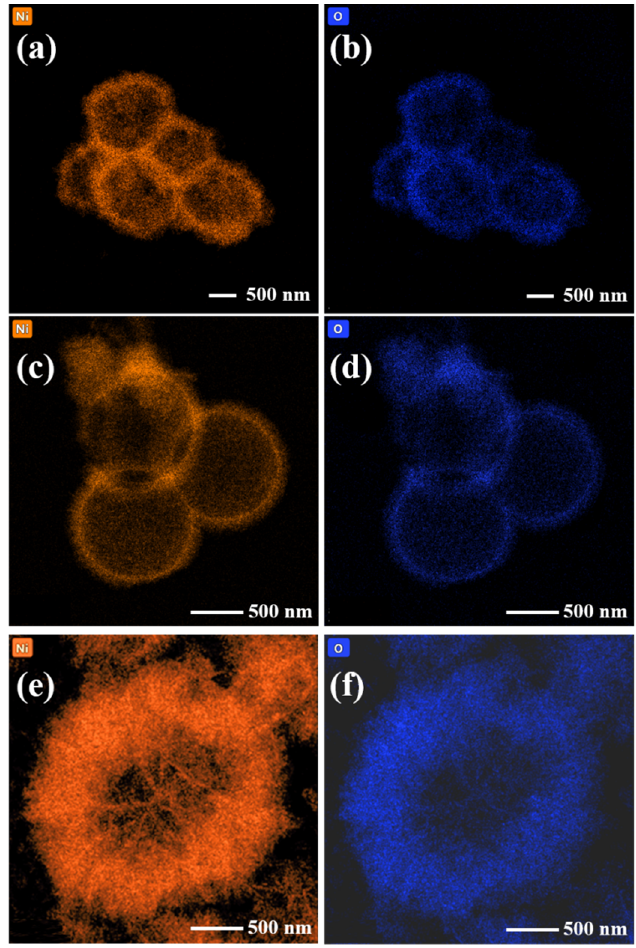
Figure 5. The EDS of ( a , b ) NiO-P, ( c , d ) NiO-N, ( e , f ) NiO-S.